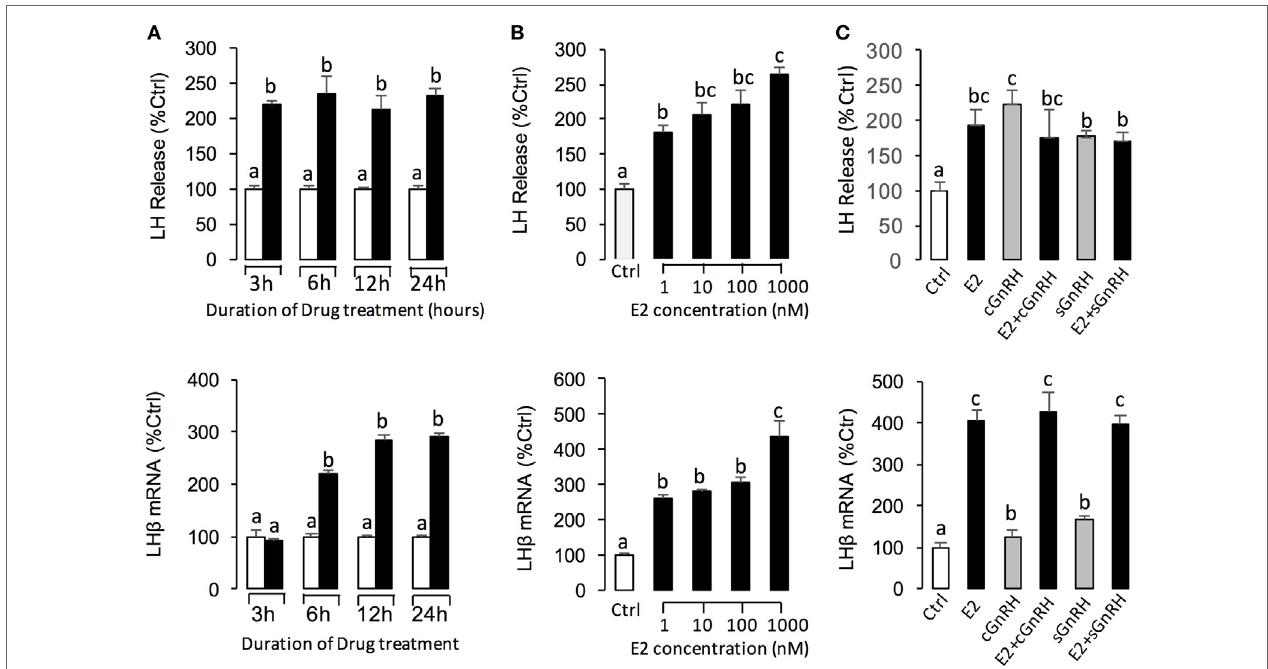
FigUre 2 | E2 induce luteinizing hormone (LH) secretion and mRNA expression in grass carp pituitary cells. (a) In the time-course experiment, pituitary cells were incubated with E2 (10 nM) for the duration as indicated. (B) In parallel studies for dose dependence, pituitary cells were challenged for 24 h with increasing levels of E2 (1–1,000 nM). (c) Effects of E2 (10 nM), sGnRH (1 µM), and cGnRH (1 µM) on LH and follicle-stimulating hormone (FSH) mRNA expression in grass carp pituitary cells. After drug treatment, culture medium was harvested for measurement of LH secretion, and the remaining cells were used for total RNA preparation for real-time PCR of the LH β and FSH β mRNA. Data presented are expressed as mean ± SEM, and groups denoted by different letters represent a significant difference at P < 0.05 (ANOVA followed by a Dunnett’s